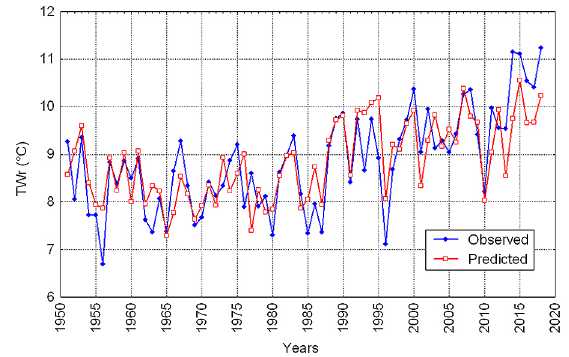
Fig. 9. The courses of the observed and predicted (from Eq. (2)) values of annual air temperature in Wrocław (TWr) in